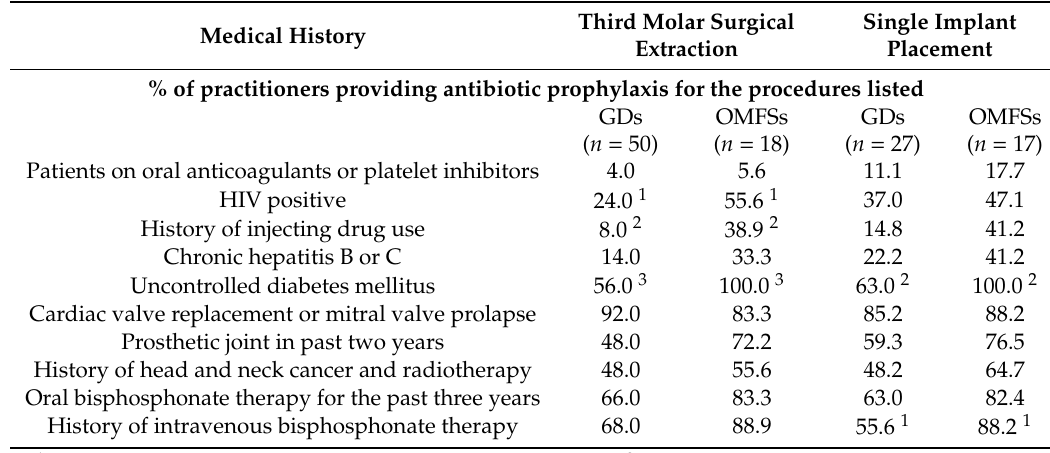
Table 5. Medical conditions for which practitioners provide antibiotic